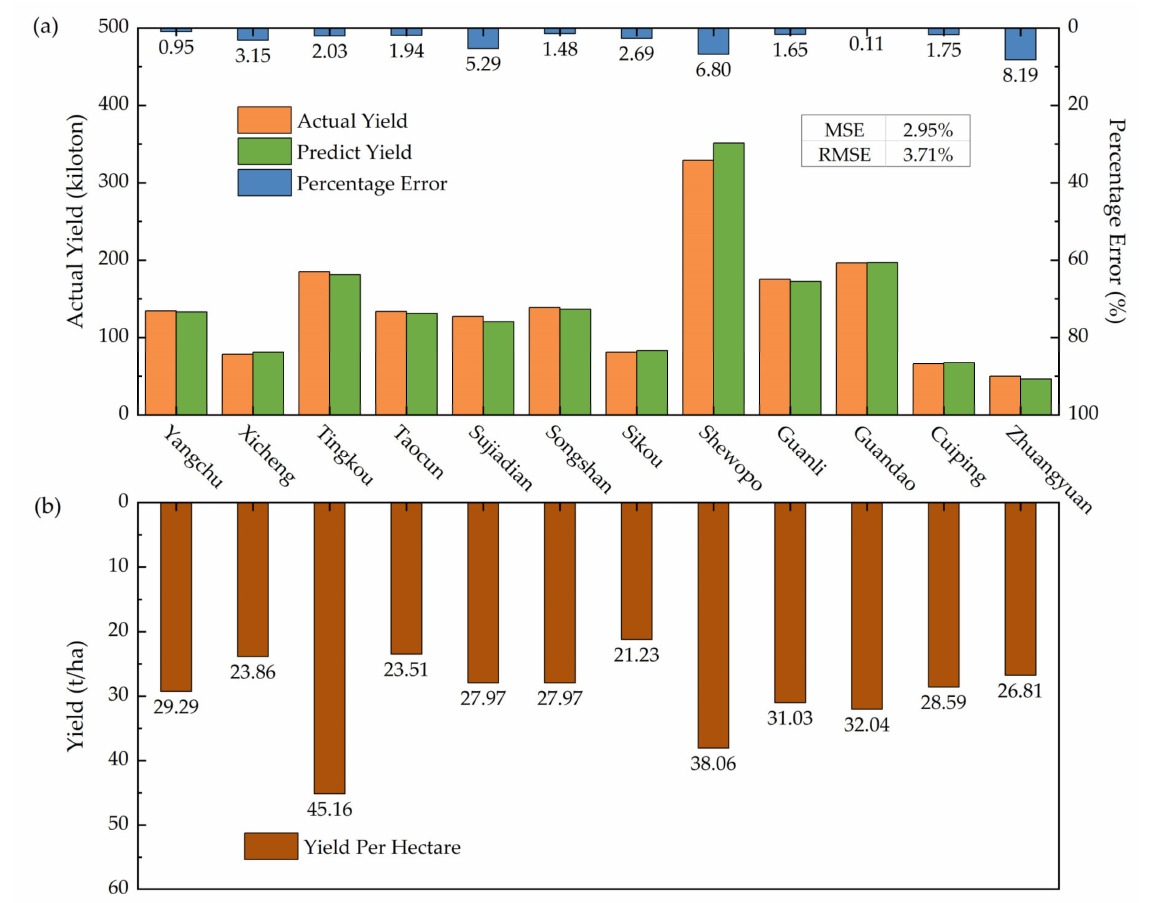
Figure 9. The 2020 prediction results and errors of counties in Qixia city. ( a ) Prediction results and error between predicted and actual yields. ( b ) Yield per